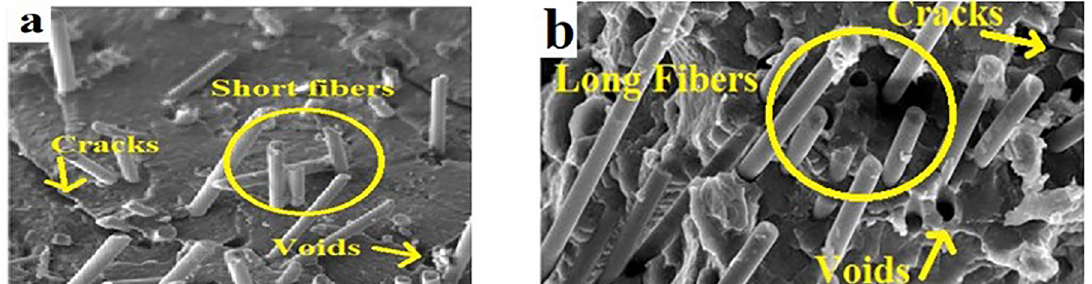
Figure 8. (a) SEM for ductile fracture of Short fibers at 14 N and (b) Long fibers at 14N